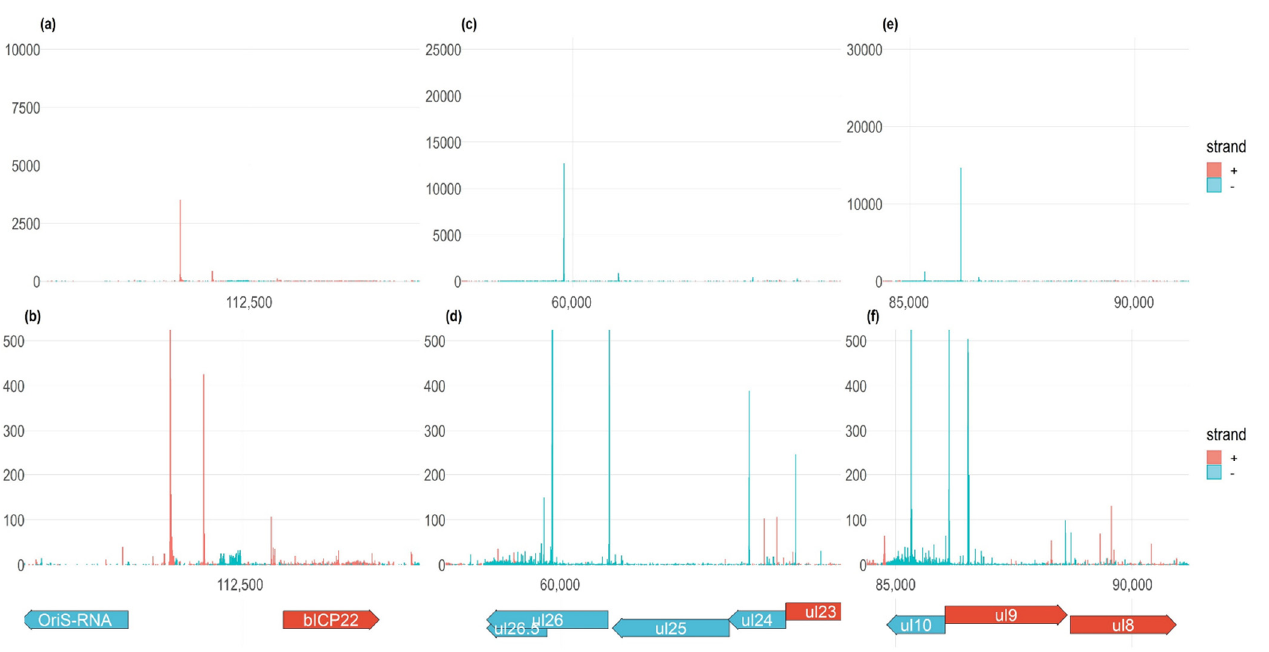
Figure 2. Examples for the alternative transcription start sites. ( a , b ) The bicp22 gene encodes a highly complex TSS pattern. There is an abundant canonical and a somewhat less abundant alternative TSS, and several rare TSSs. ( c , d ) Transcripts of ul26.5-26 genes are illustrated by using the original abundance without setting a limit, (B) and an abundance restricted to 500 TSSs (C). The ul26.5 gene is transcribed at a higher level than the ul26 gene. ( e , f ) Transcripts of ul10 gene are illustrated by using the original abundance (D) and an abundance restricted to 500 TSSs (E). Besides the canonical TSS, ul10 is also expressed to contain two alternative TSSs. All examples are from the 12 hpi samples.